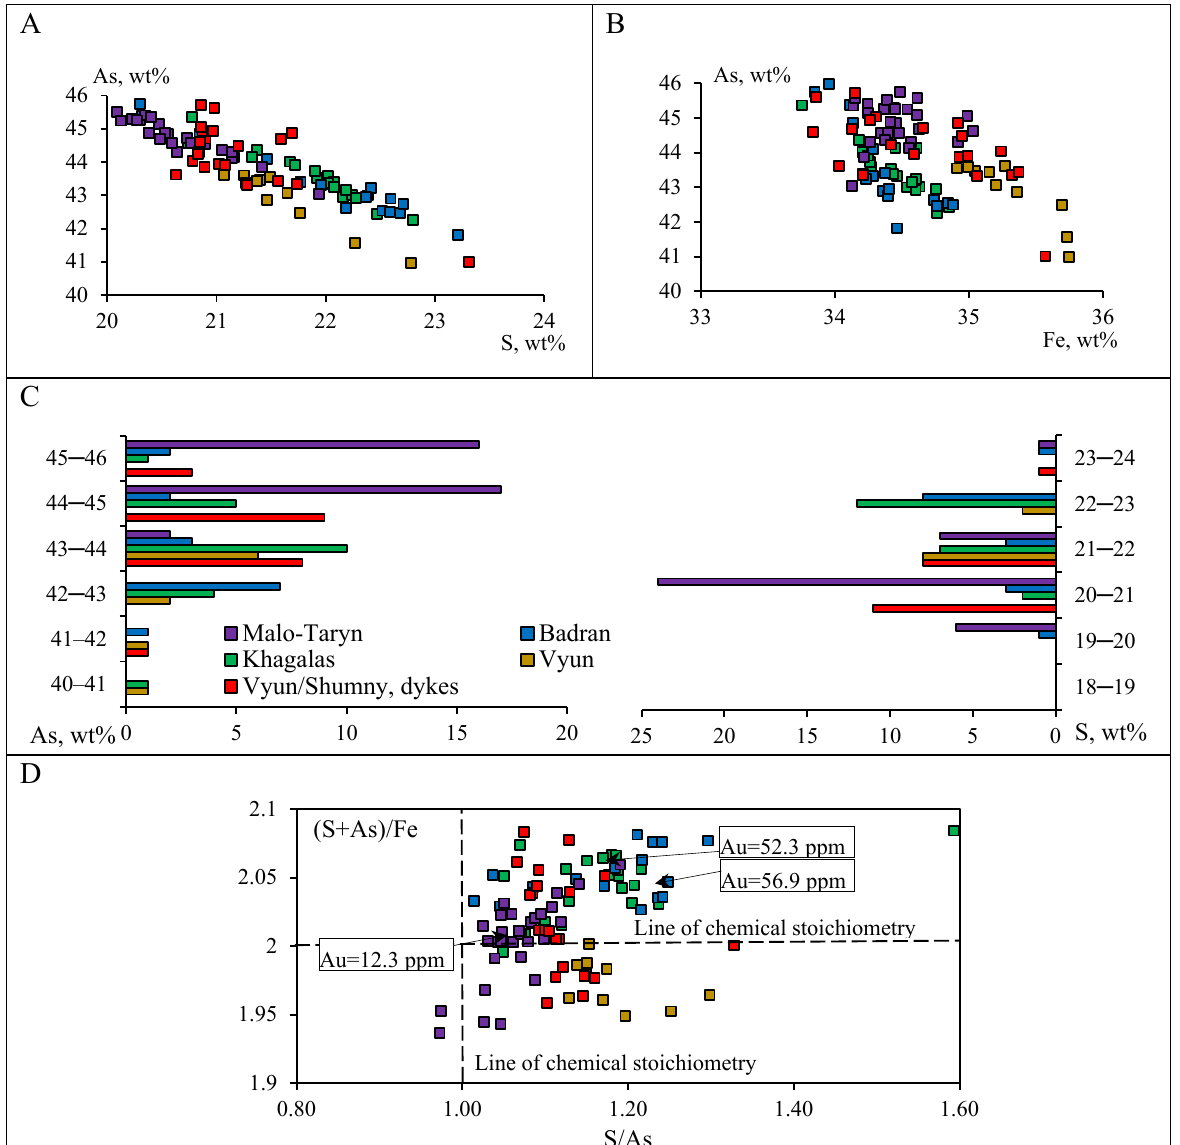
Figure 18. Diagrams of the ratios of concentrations of Fe, S, and As in Apy1 of the studied OGDs, central YKMB. ( A ) As vs. S. ( B ) As vs. Fe. ( C ) Variations in the S and As content in the studied deposits; ( D ) diagrams of the ratios S/As and (S + As)/Fe. The intersection of the lines S/As = 1 and (S + As)/Fe = 2 corresponds to chemical stoichiometry. See symbols in Figure 16. A diagram of S/As and (S+As)/Fe [111] clearly reflects both the nonstoichiometry and variability of the compositions, as well as the increased sulfur content of Apy3 in the studied deposits (Figure 18). The deficit of Fe and As is compensated by the trace elements (Co, Ni, Cu, Sb). They can occupy both anionic and cationic vacant positions in the crystal structure, and their distribution in arsenopyrite is less ordered than in pyrite. Slight and moderate negative correlations prevail between the main elements and trace elements (Figure 19). The connection between As and Sb is most clearly manifested (r = − 0.45– − 0.61) (Figure 19L). For alteration arsenopyrites with nonstoichiometric composition and a predominance (excess) of S, many researchers [39,112,113] specify the increased concentrations of Au. The following trend can also be observed in the deposits studied by us (Figure 18D). Significant variations in the S, As, and Fe and trace ‐ element content in the arsenopyrite also indicate the crystallization of the mineral in an inhomogeneous temperature field [111]. This is reflected in the zonal distribution of both trace elements and the gold content of Apy3.